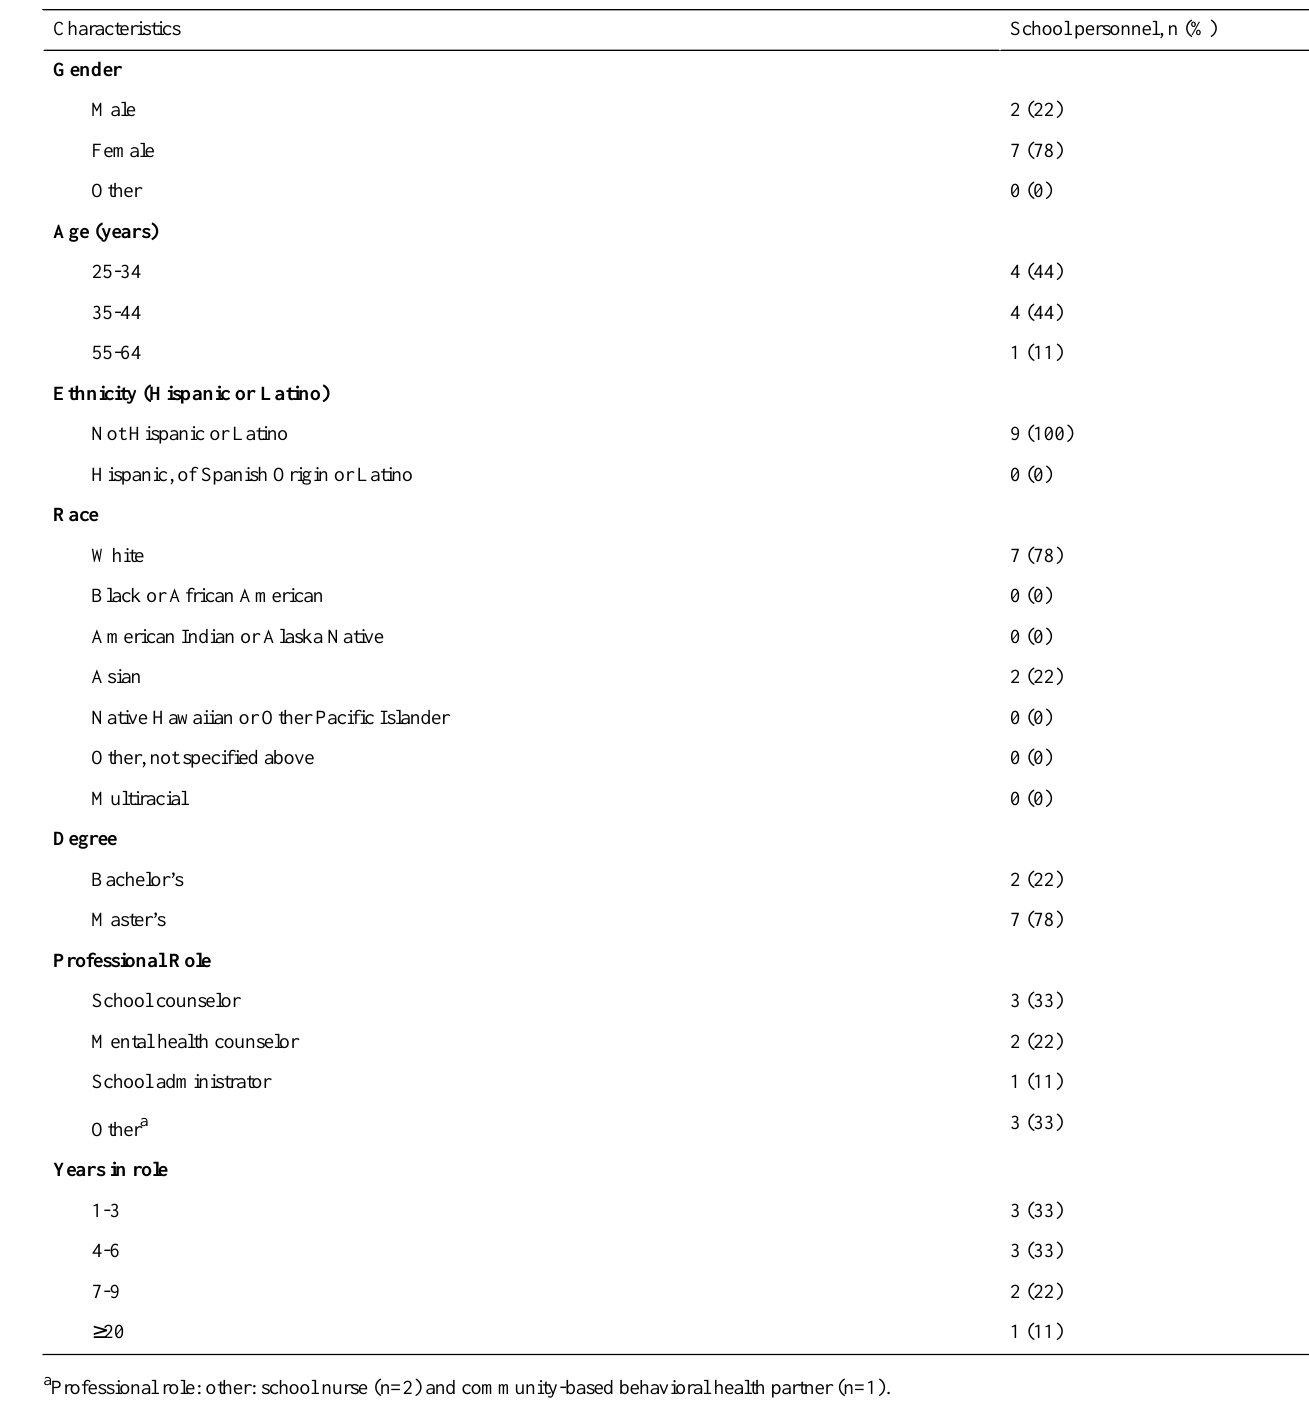
Table 3. Summary of demographics for school personnel participants